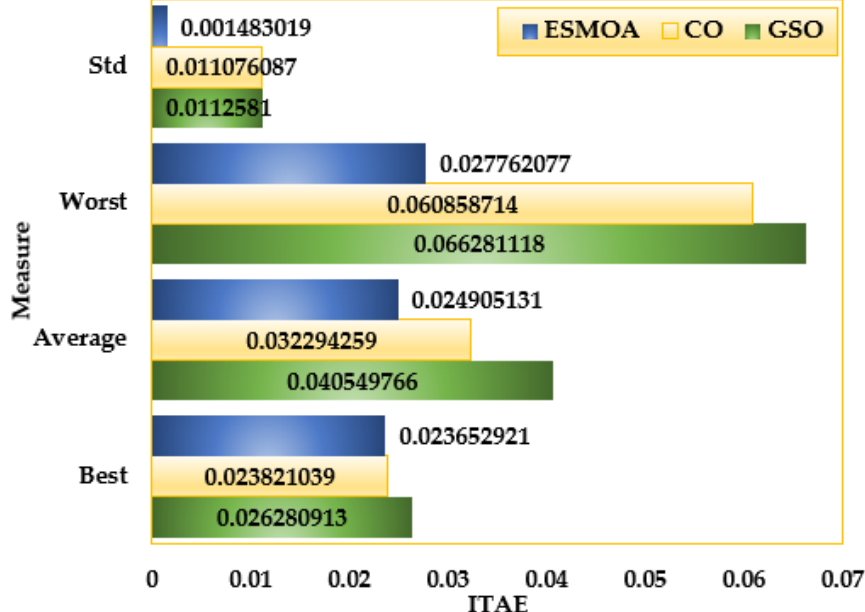
Figure 10. Statistical measures for CO, GSO, and the proposed ESMOA for Case 2.